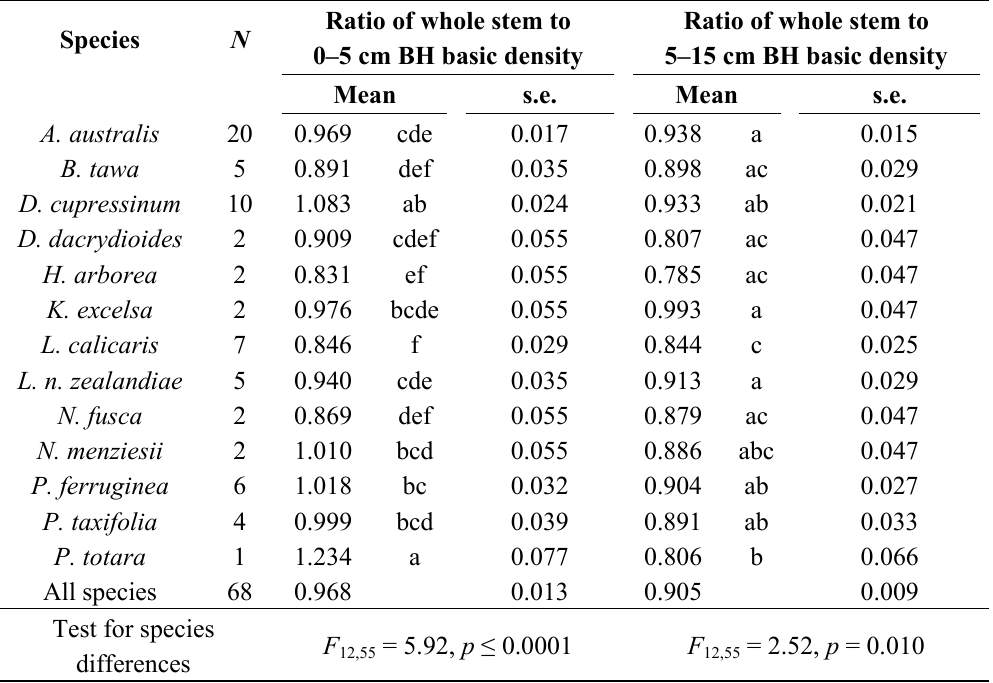
ratios of whole stem and branch density to breast height outerwood basic density by species and over all species. Values in a column followed by the same letter do not differ significantly (least significant difference test with p =